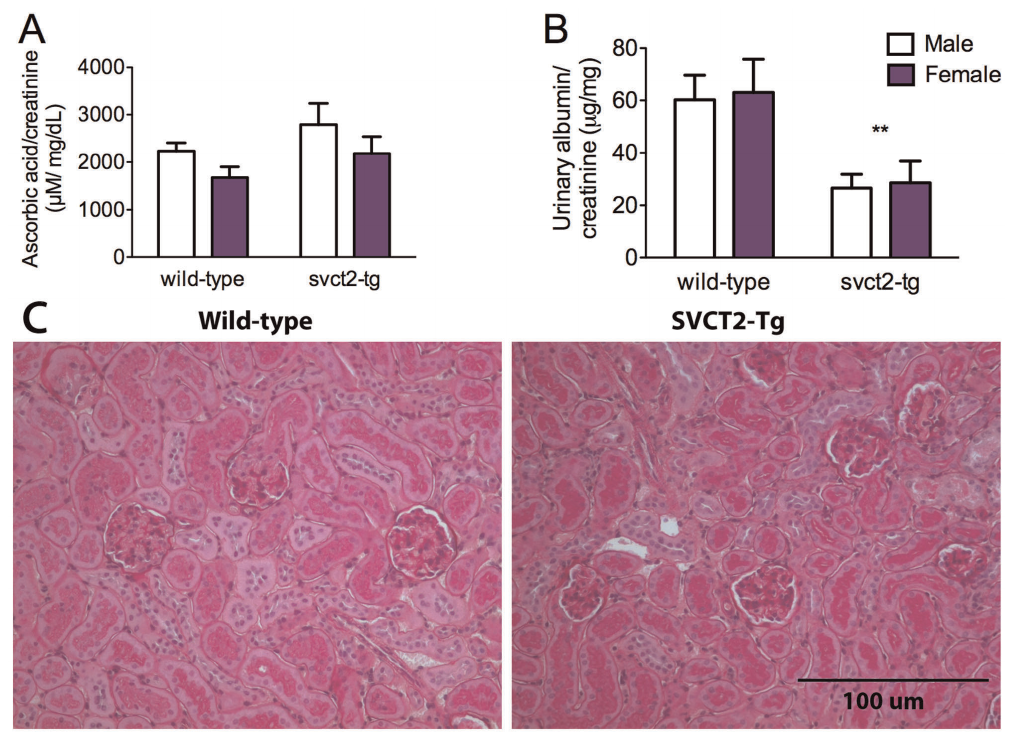
Figure 4. Kidney Function in SVCT2-Tg mice. Excreted (A) ASC and (B) albumin were measured in urine samples with the results normalized to creatinine. Data shown are mean + S.E.M for wild-type and SVCT2-Tg mice separately for male (white bars) and female (purple bars) mice. ** p , 0.01 compared to wild-type control. N=5 2 6 mice per group. (C) 2 m m sections stained with hemotoxylin and eosin (H&E) for comparison between genotypes. Glomeruli, proximal tubules and distal tubules are all clearly visible but no changes were observable in SVCT2-Tg mice (right panel) compared to wild-types (left panel). Images taken at 20X magnification.